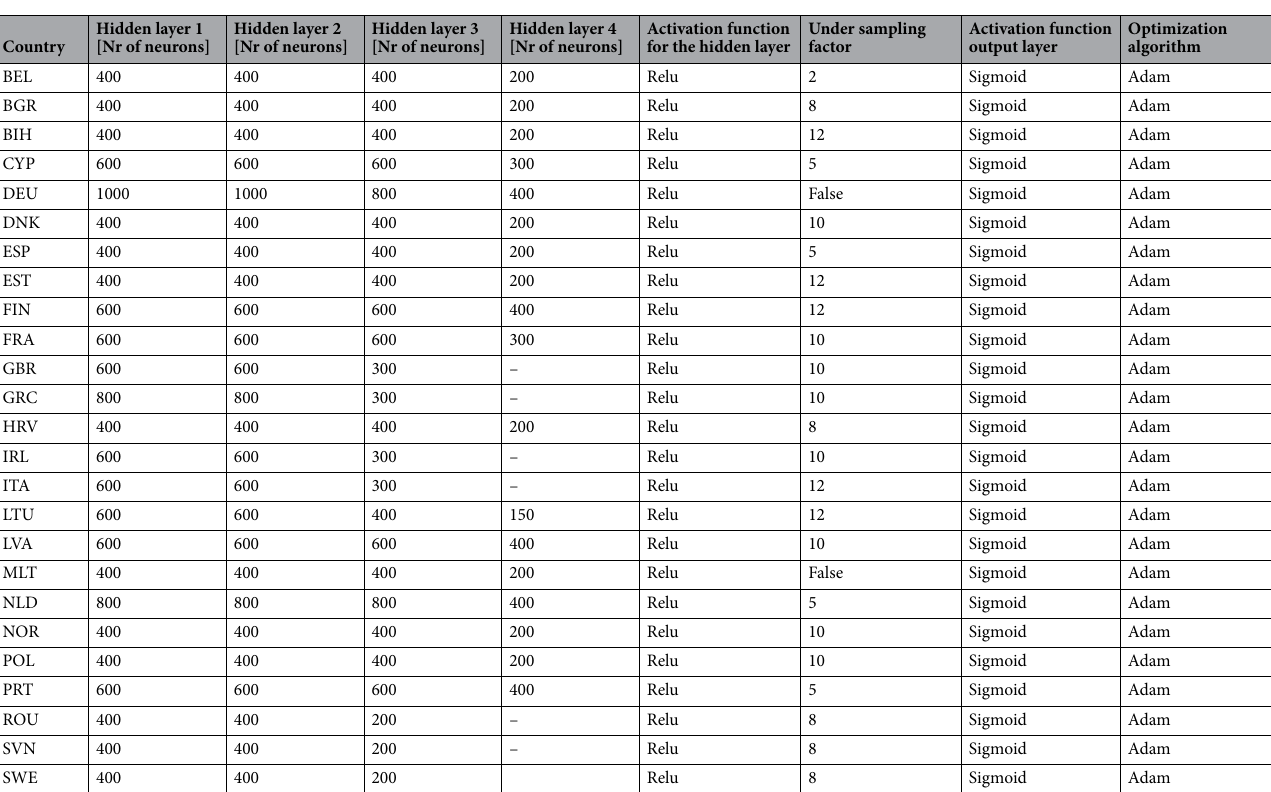
Table 3. Best performing MLP model architecture per